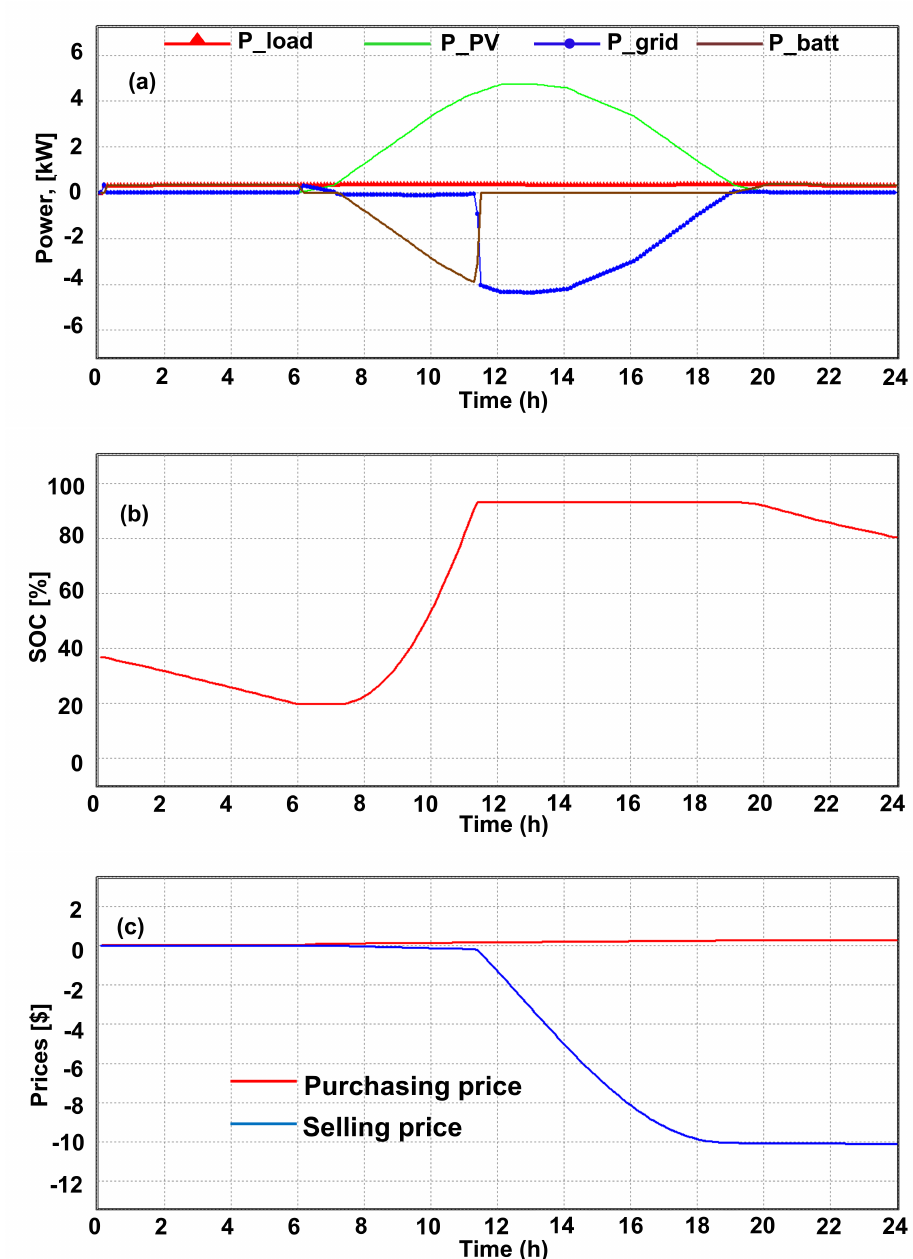
Figure 8. Power flow in summer: ( a ) PV output power, grid, battery power, and power demand; ( b ) State of charge; ( c )